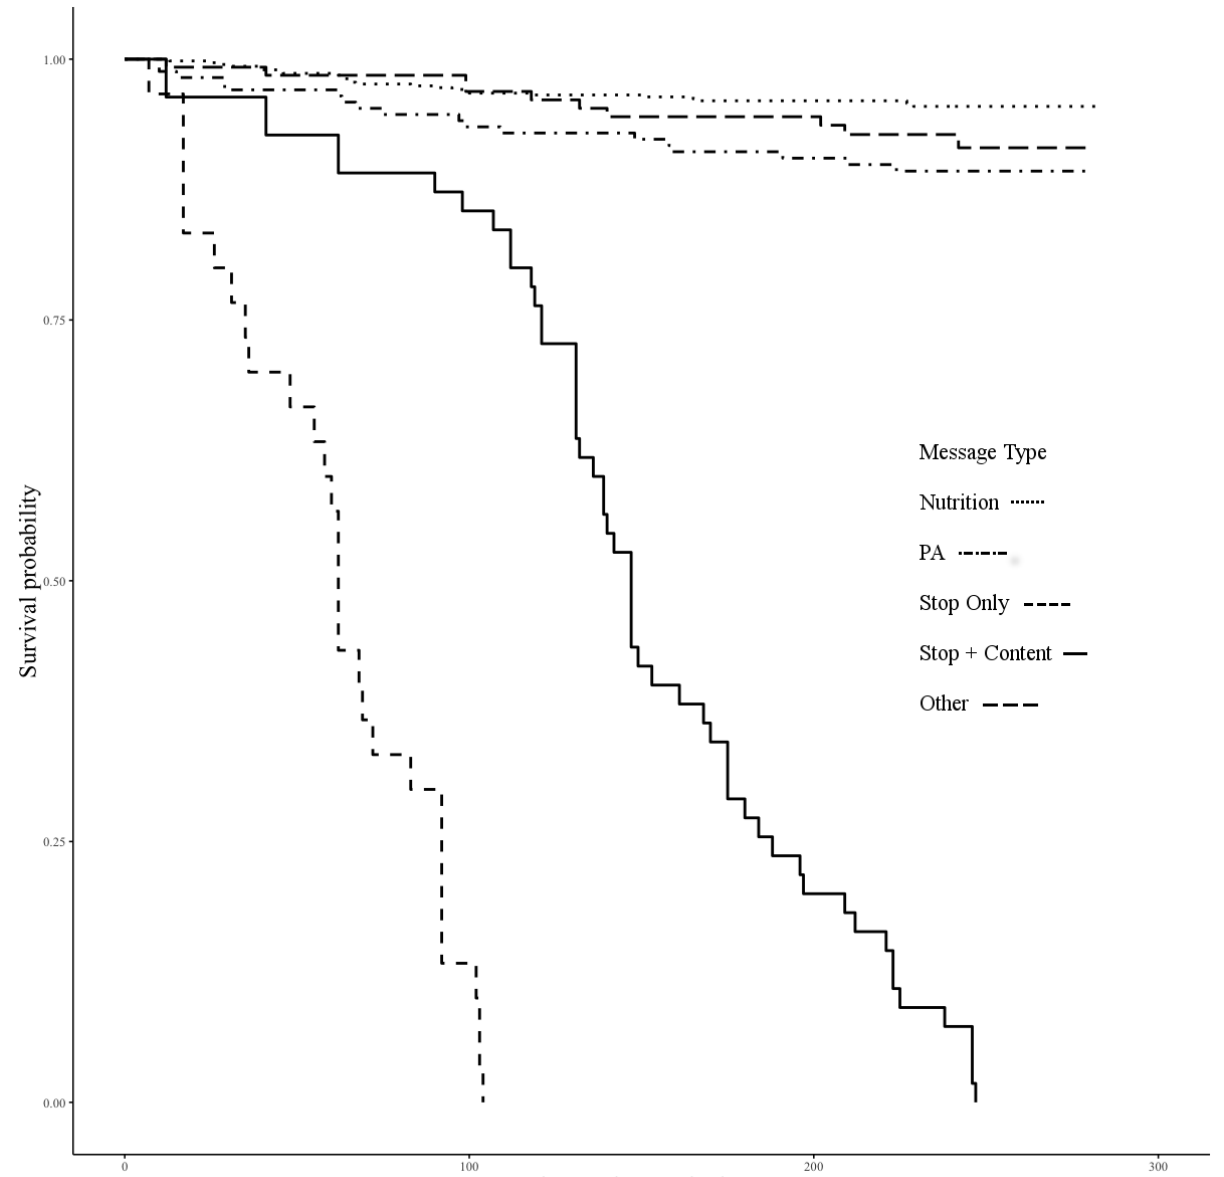
Figure 1. Kaplan-Meier survival curves by message